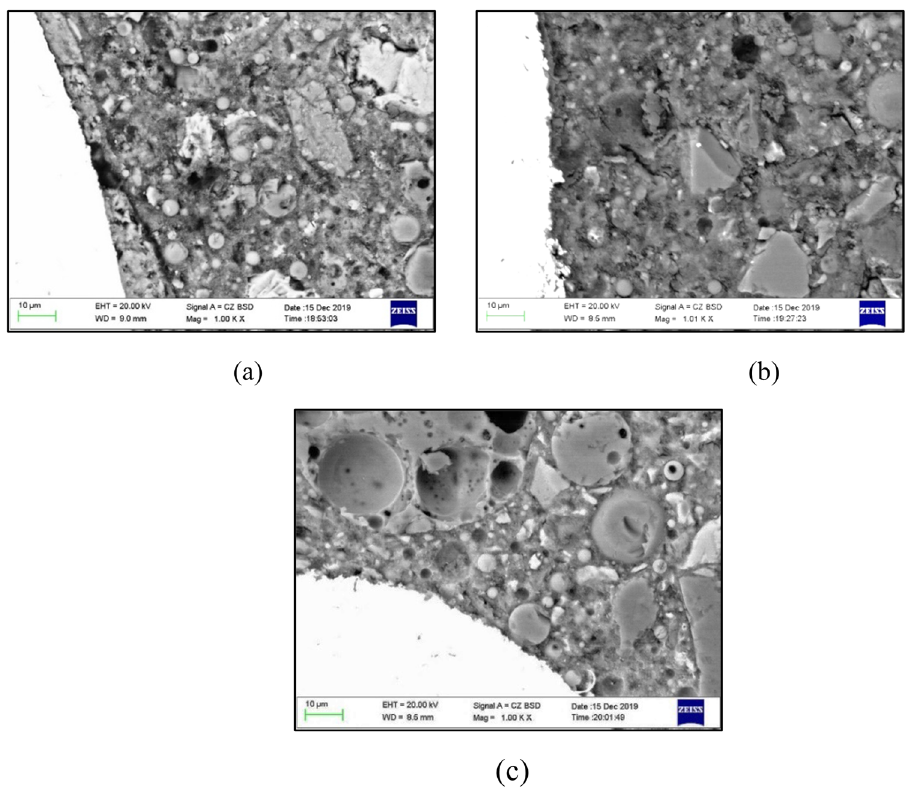
Figure 10: BSE image of interface between a fi ber and the bulk matrix at 7 days: ( a ) referenced specimen without GO; ( b ) specimen with 0.02% of GO under standard curing; and ( c ) specimen with 0.2% of GO under steam